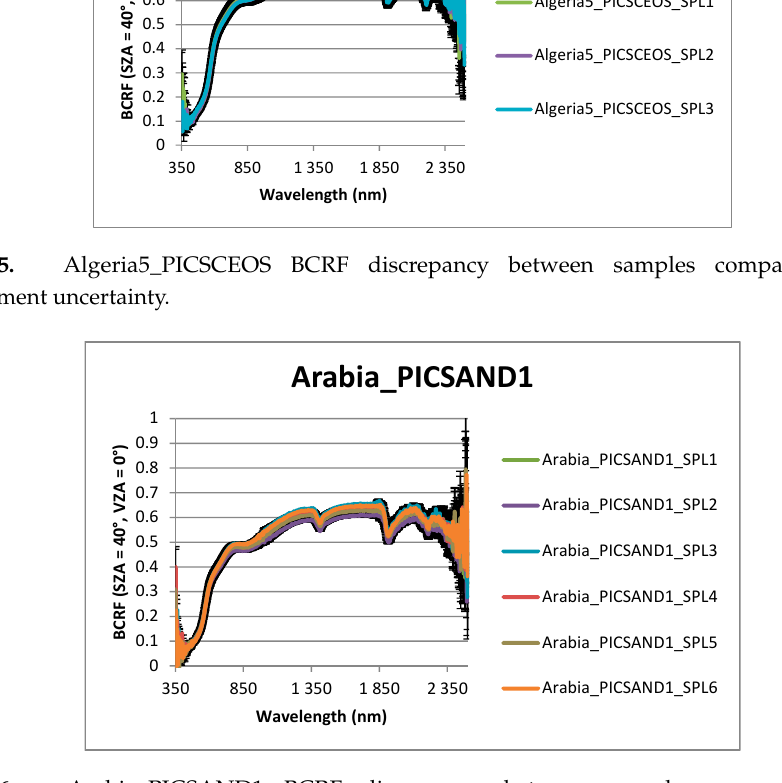
uncertainty . measurement uncertainty.